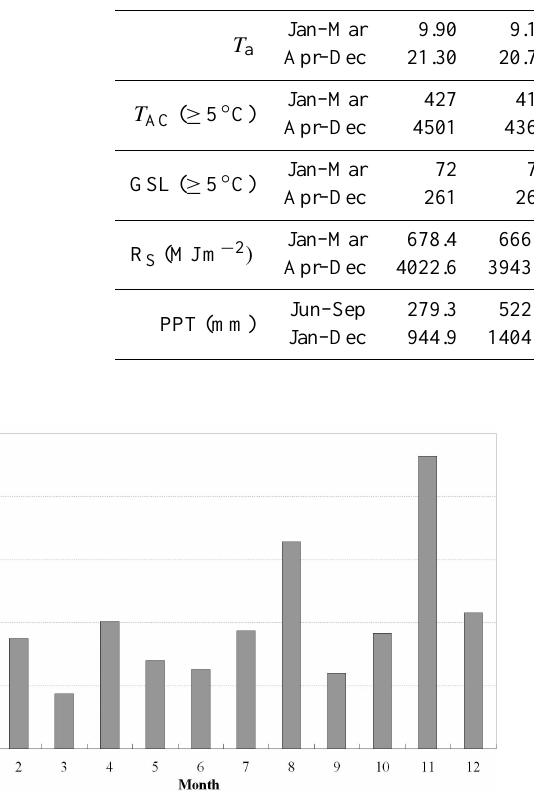
Fig. 4. The monthly measured litter of QYZ ecosystem during 2004–2007.